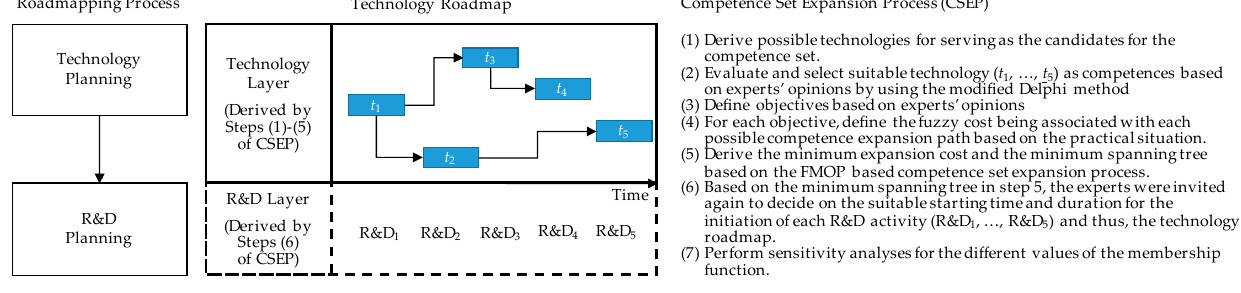
Figure 2. The roadmapping process, technology roadmap, and the competence set expansion process. Source: Adapted from [84].